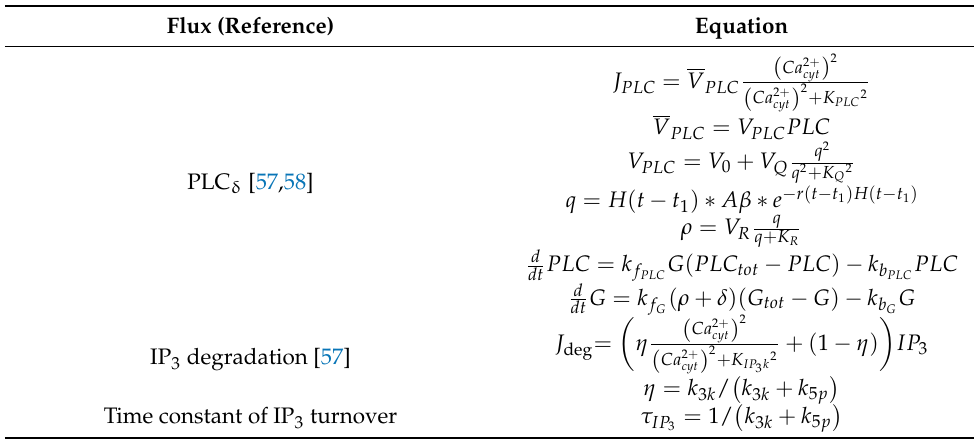
Table 4. IP 3 fluxes in the